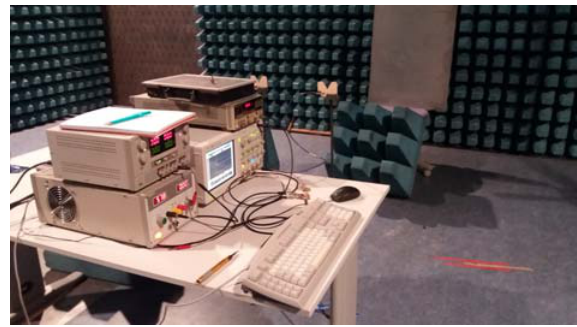
Figure 14: Photograph of measurement setup and Photo- graph of UWB impulse generator.